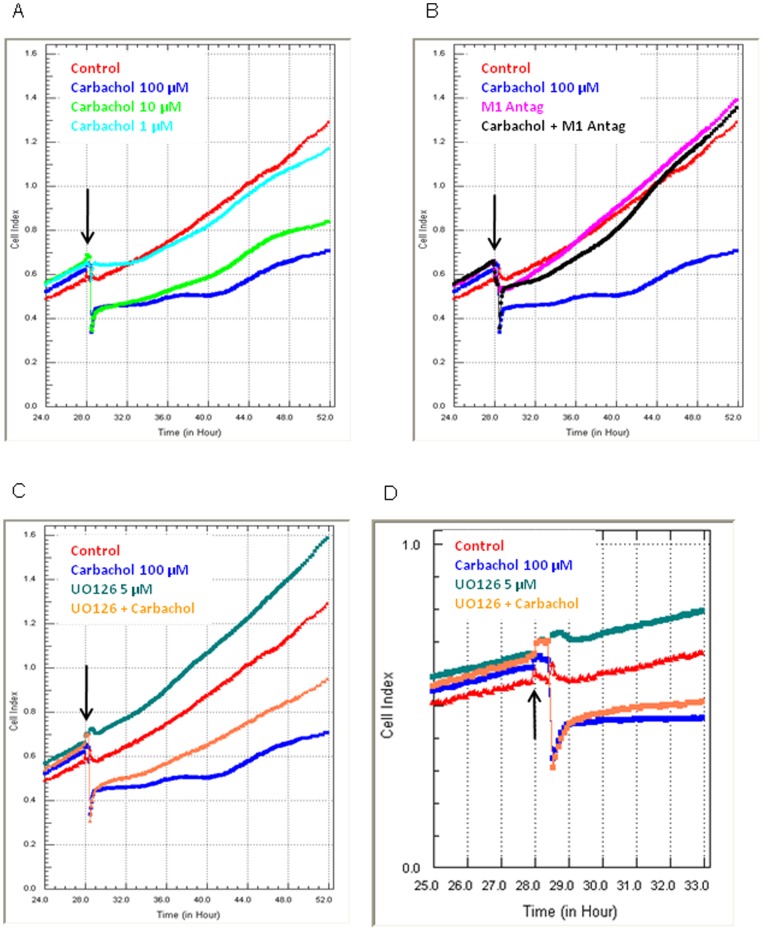
Analysis of carbachol mediated cell death using xCELLigence technology.HEK293-M1 cells were stimulated with various concentrations of carbachol (A), in the presence (or absence) of a M1 selective antagonist (B), and with 5 µM UO126 (C and D). Panel D shows the period immediately following drug addition to highlight the immediacy of the carbachol response. In each graph the black arrow shows the time point the respective drugs were added. Cellular measurements are made continuously in real time, where the level of total cell adhesion is represented as Cell Index. Higher Cell Index levels represent more adhesion, whereas a reduction in Cell Index represents a loss of adhesion. In all four graphs the red and blue Cell Index curves are the same and represent vehicle-treated and 100 µM carbachol-treated HEK293-M1 cells. The reduction in adhesion mediated by carbachol is immediate, concentration-dependent, blocked by M1 antagonist, but not blocked by UO126 (MEK blocker). xCELLigence data show representative Cell Index curves of at least six independent experiments.